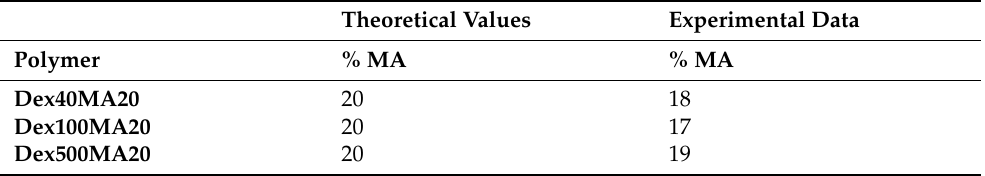
Table 2. Theoretical and experimental degree of methacrylation (% MA) of Dex40MA20, Dex100MA20, and Dex500MA20. The degree of methacrylation, defined as the number of methacrylated groups per 100 glucopyranose residues of dextran, was determined via proton NMR at 300 MHz. Dex40MA20: Dextran 40 kDa with a theoretical methacrylation degree of 20%, Dex100MA20: Dextran 100 kDa with a theoretical methacrylation degree of 20%, Dex500MA20: Dextran 500 kDa with a theoretical methacrylation degree of